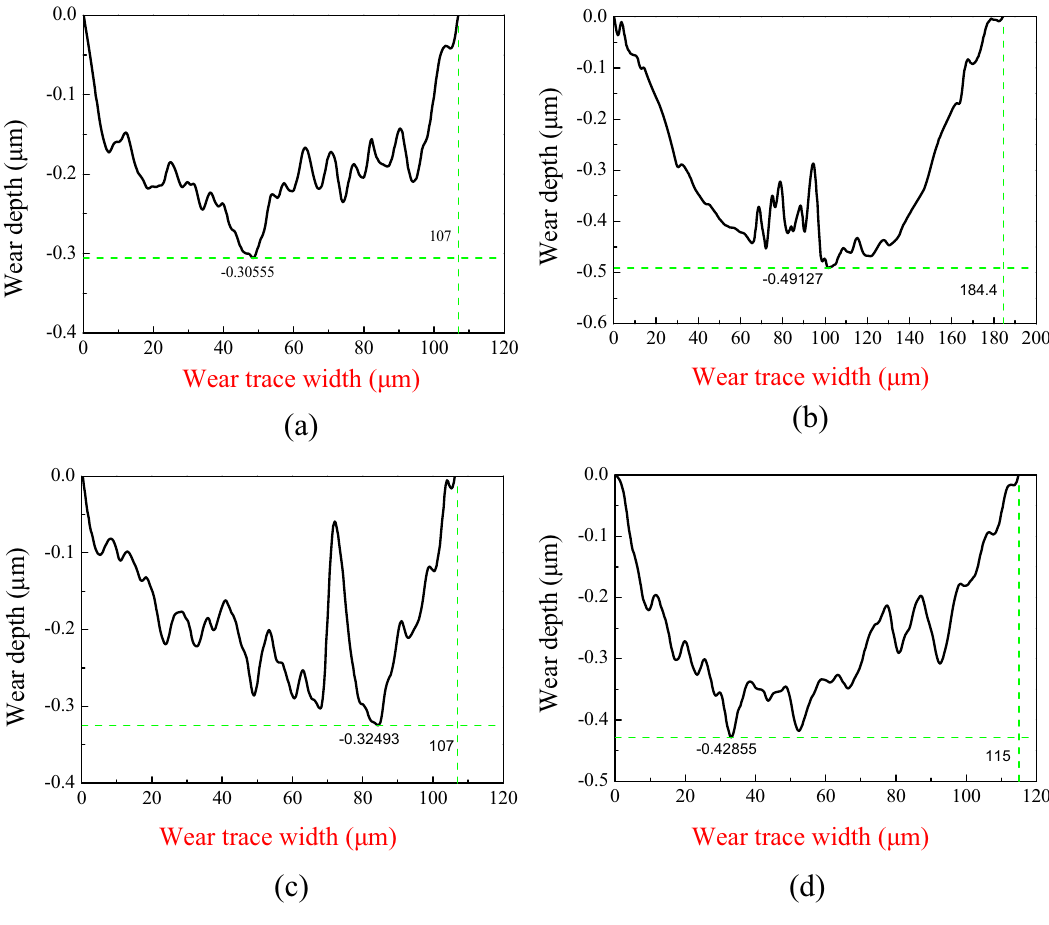
Figure 6: Surface pro fi le of wear traces: ( a ) substrate, ( b ) TiN, ( c ) TiAlN, ( d )